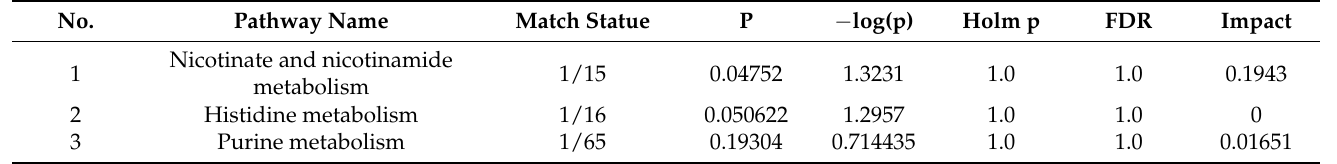
Figure 6. Metabolic pathways of urinary differentials before training compared to immediate post-competition. Table 5. MetPA analysis of metabolic pathways for post-training and post-competition differential metabolites.